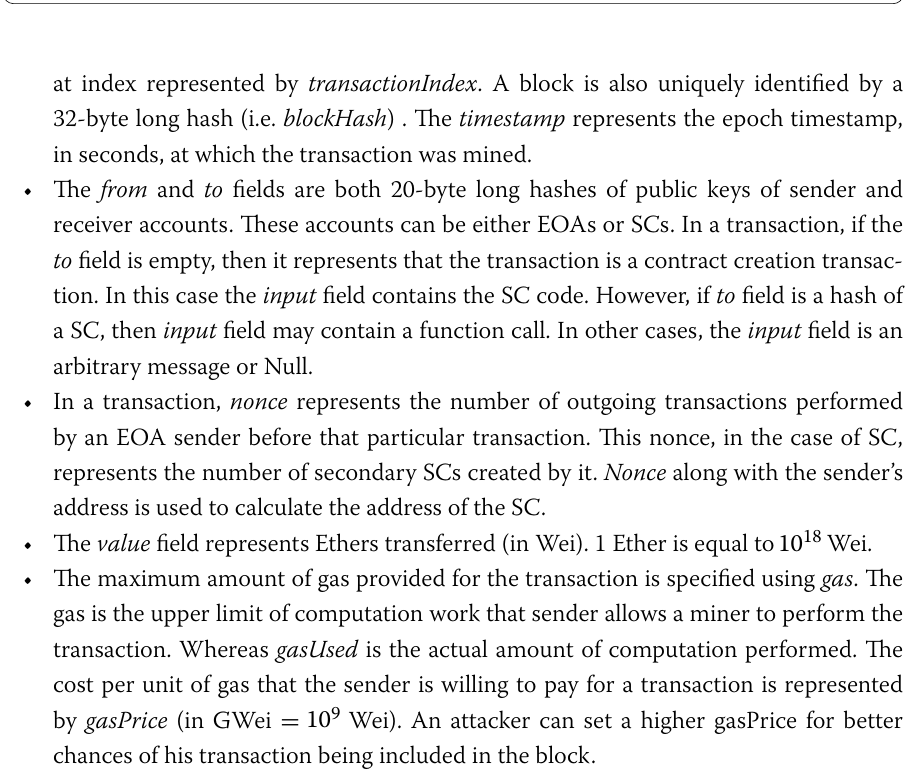
Fig. 4 A sample Ethereum